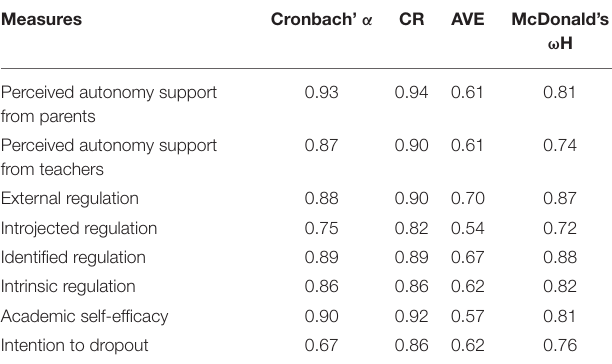
TABLE 1 | Cronbach’s Alpha, Composite Reliability (CR), Average Variance Extracted (AVE), and McDonald’s Omega for the measures used in the